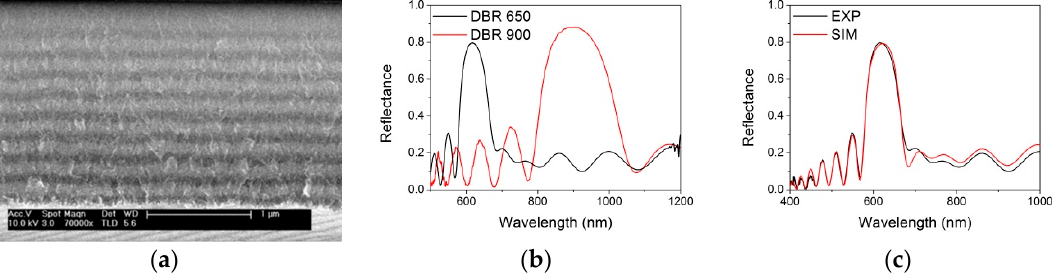
Figure 2. ( a ) Scanning electron microscopy (SEM) image of the cross section of the distributed Bragg reflectors (DBR) centered at 650 nm. ( b ) Reflectance spectrum of the DBR centered at 650 nm (black line) and at 900 nm (red line). ( c ) Comparison between experimental (black line) and calculated (red line) reflectance spectra for the DBR centered at 650 nm.